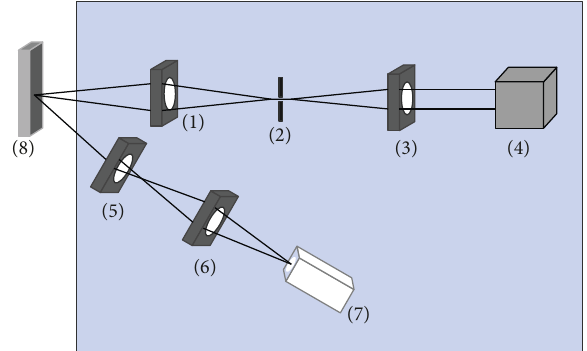
Figure 3: Schematic diagram of the infrared identification system for monitoring materials.